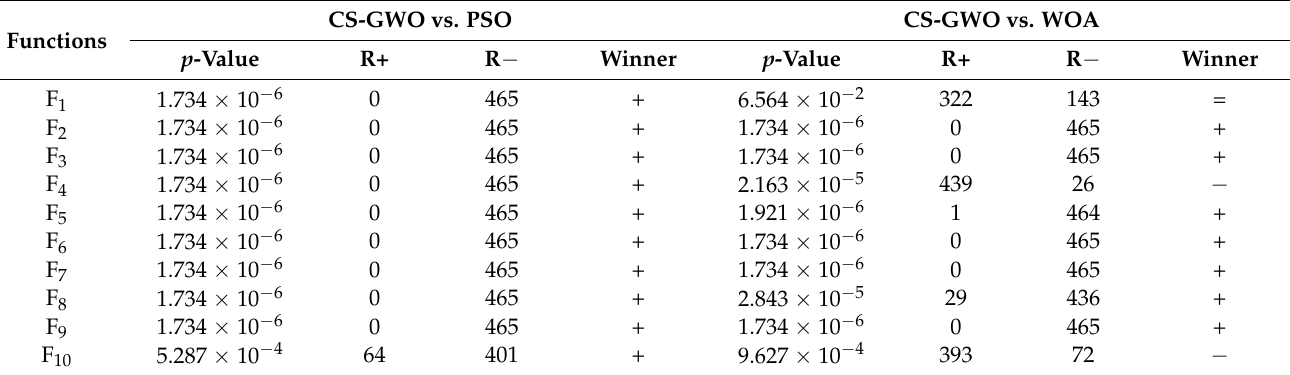
Table 4. Wilcoxon signed-rank test results of CEC